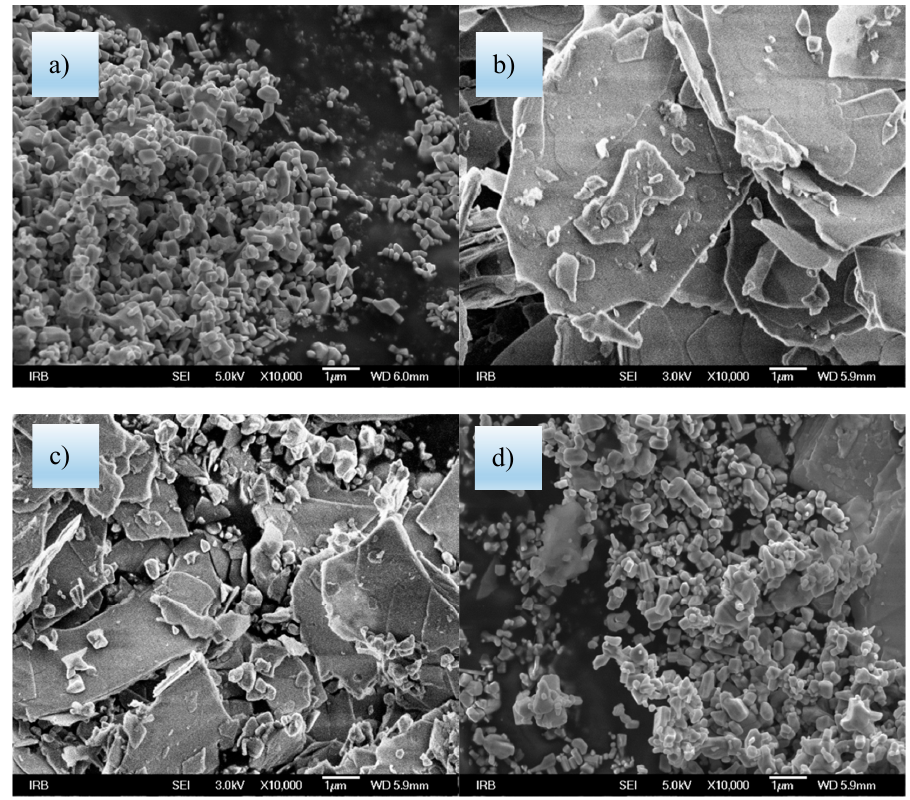
Figure 4. FE-SEM images of pure ( a ) ZnO, and ( b ) PANI/ZnO_1, ( c ) PANI/ZnO_2, and ( d ) PANI/ZnO_3 samples. Images ( b ), ( c ), and ( d ) show the impact of the prolonged stirring time on the morphology of prepared PANI/ZnO samples. Composites particles size: PANI/ZnO_1 > PANI/ZnO_2 > PANI/ZnO_3.